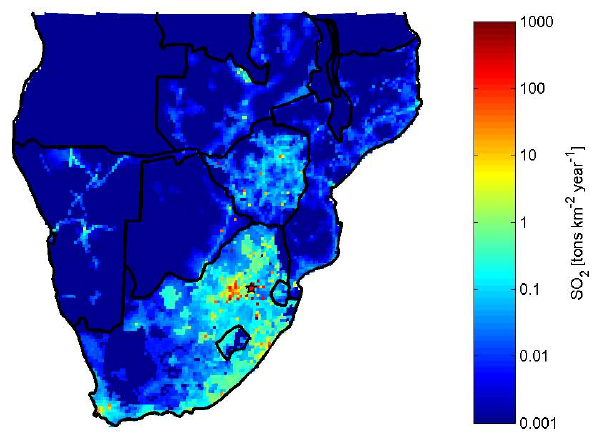
Fig. 3. Total SO 2 -emissions based on SAFARI2000 emission in- ventory (Fleming and van der Merwe, 2004). The measurement site is indicated with a red